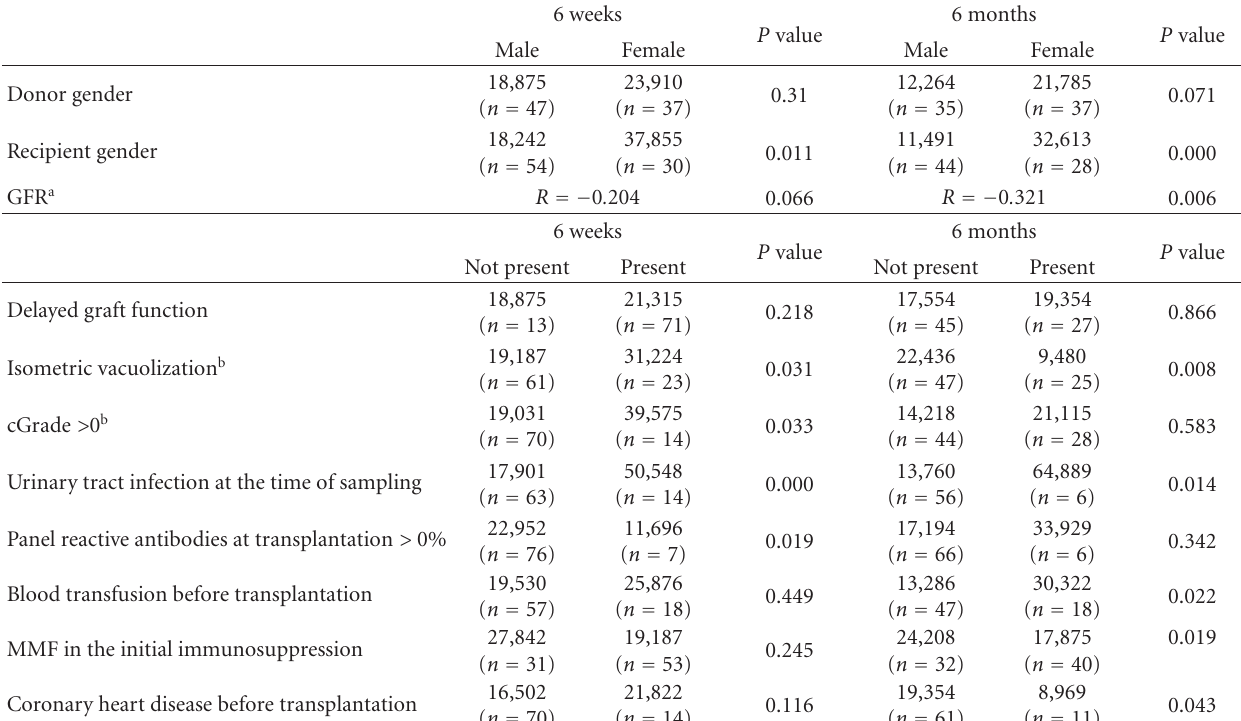
Table 2: Urinary NGAL levels (NGAL/creatinine; (ng/g)), and associations with various clinical, laboratory and demographic variables. Results are separately reported for the 6-week and 6-month samples. The remaining variables which were tested without significant di ff erences are reported in the Supplementary